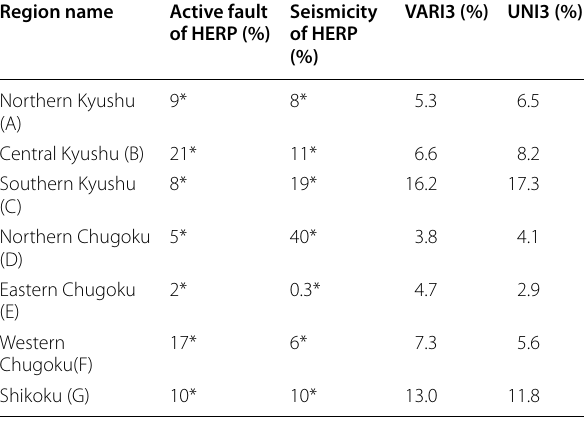
Table 5 Comparison of 30-year probability of M earthquakes with the HERP regional